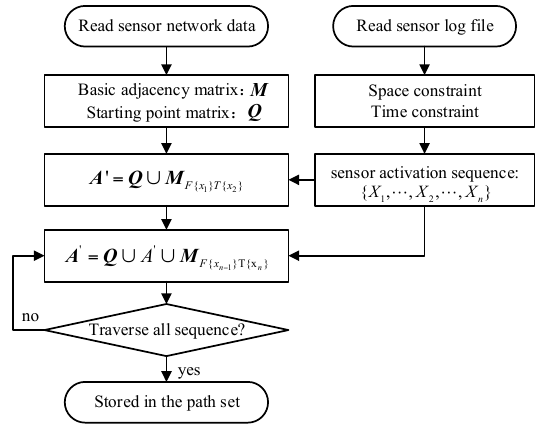
Figure 6. The process of the trajectory generation and refinement algorithm.